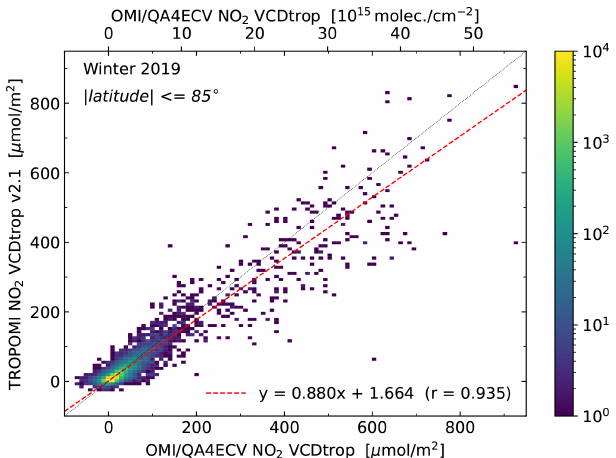
Figure 13. As Fig. 12 but for TROPOMI v2.1 data vs. OMI/QA4ECV